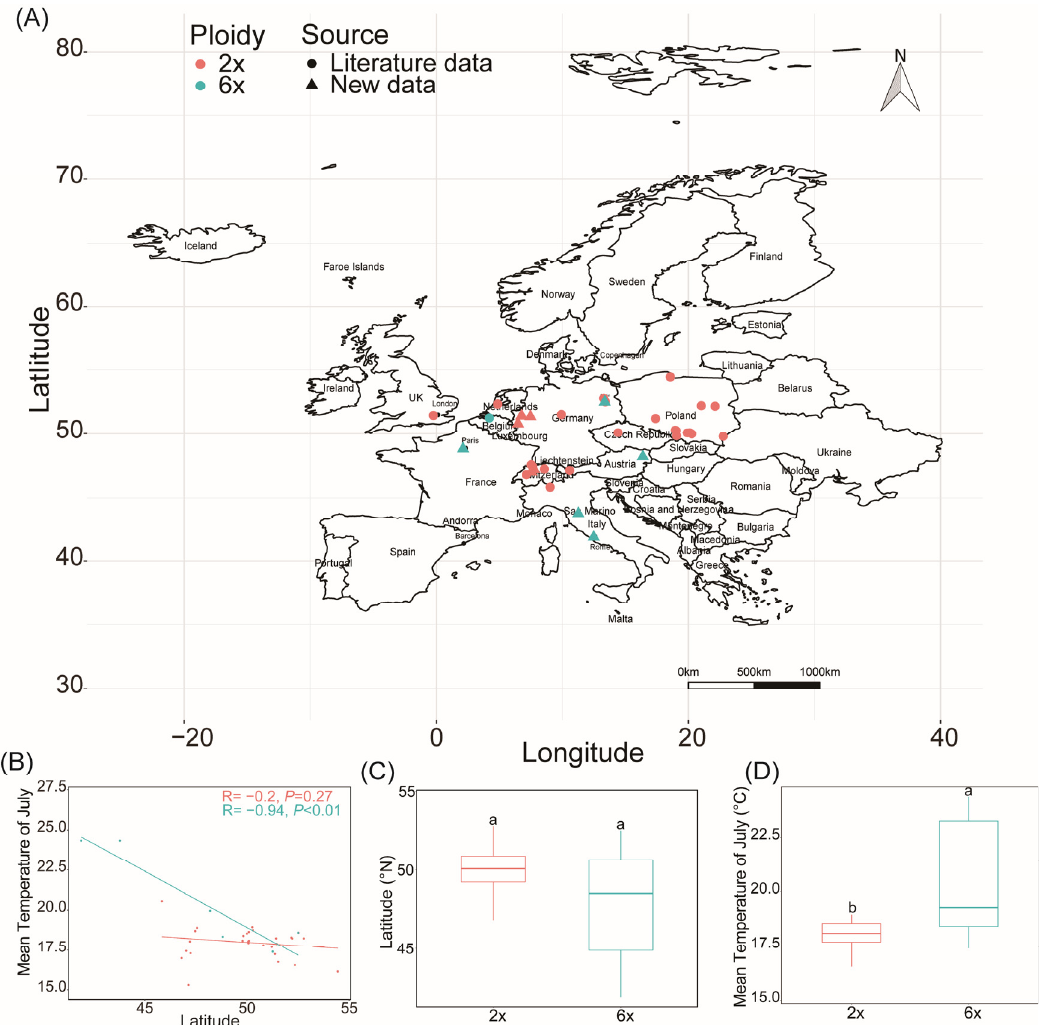
Figure 4. Distribution of different cytotypes of S. canadensis in Europe. ( a ) Distribution of different ploidy populations in Europe, ( b ) geographical differentiation of different ploidy populations, ( c ) comparison of latitudes, and ( d ) mean temperatures of July of different ploidy populations. Different lowercase letters indicate significance.